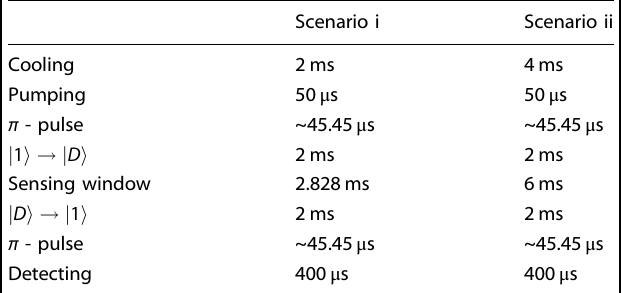
Table 3. Experimental timings for two scenarios ( ‘ Idle ’ and ‘ MW trigger ’ are not